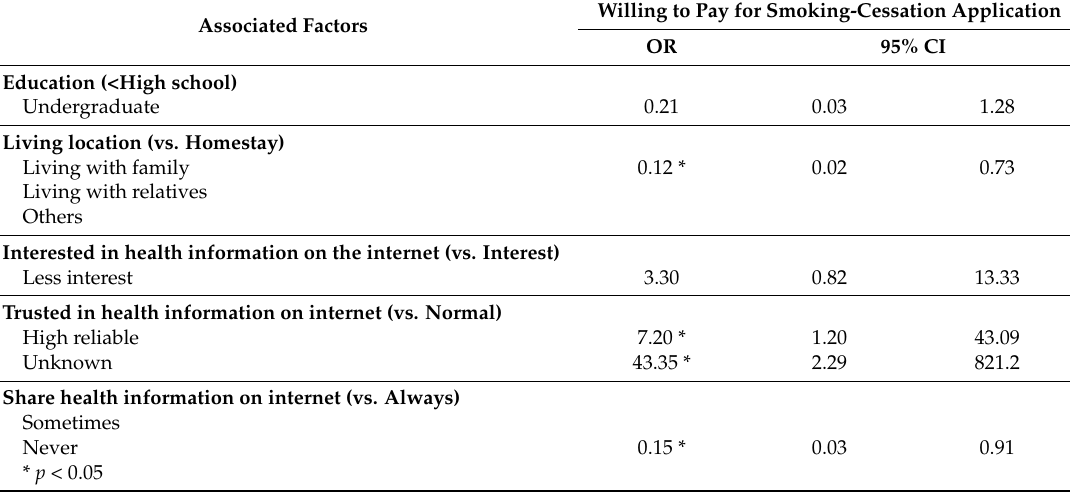
Table 5. Associated factors with the willingness to pay for smoking-cessation application ( n =